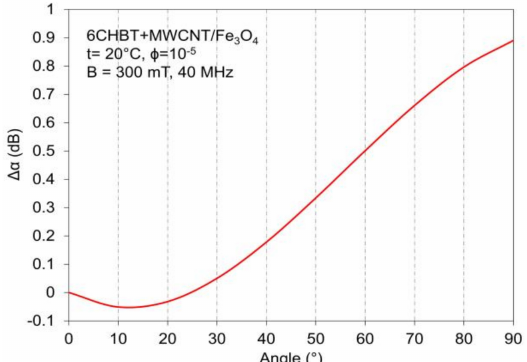
Figure 8. Anisotropy of SAW attenuation measured at B = 300 mT for 6CHBT doped with nanorods of di ff erent concentrations (5 × 10 − 5 , 5.2 × 10 − 4 ).